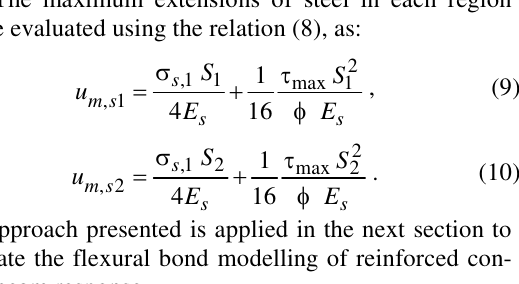
Table 1. Material properties used in application